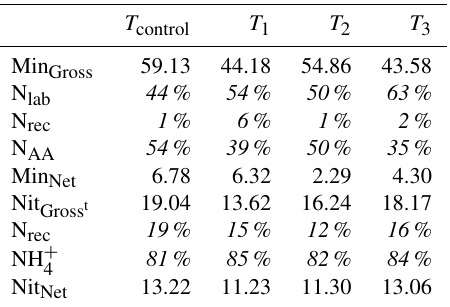
Table 2. Gross mineralization (Min Gross ), net mineraliza- tion (Min Net ), gross nitrification (Nit Gross ) and net nitrifica- tion (Nit Net ) rate in µgNgsoil − 1 day − 1 . Including the contribu- tions from the different N pools for the gross transformations (ital- ics), where N lab is a labile organic N pool, N rec is a recalcitrant organic N pool, NH + is the ammonium pool and N AA is the amino 4 acid Gly pool. t indicates one-way ANOVA tendency p <